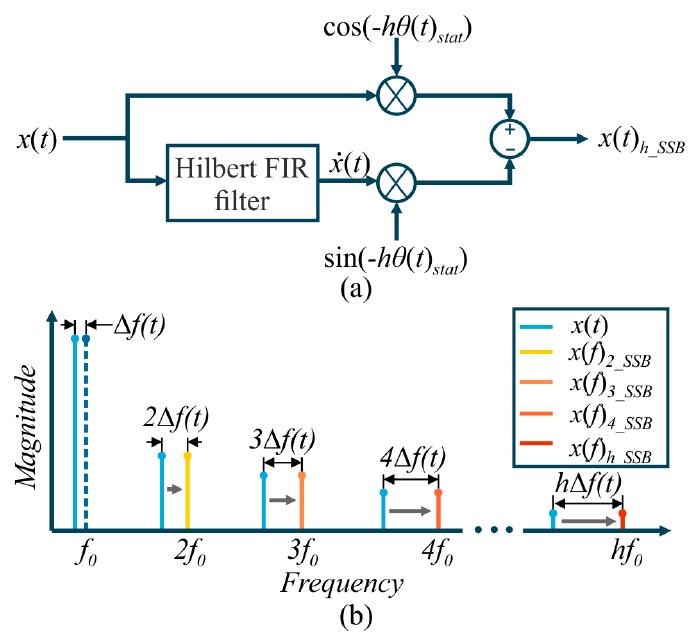
Figure 3. ( a ) Instantaneous SSB modulation diagram and ( b ) the frequency shift for each harmonic component.